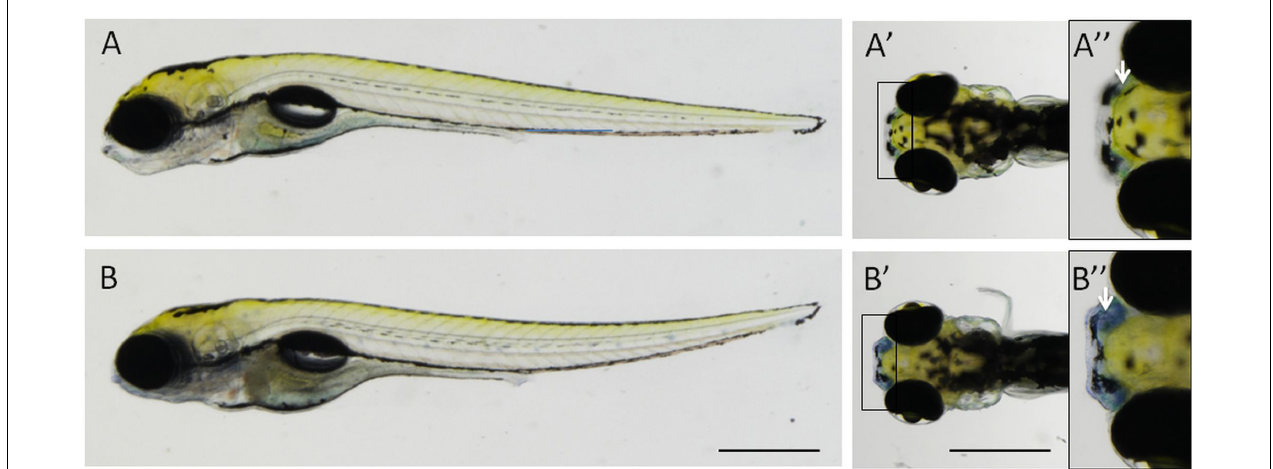
FIGURE 2 | Nile blue staining distinguishes npc2 − / − fish from wildtype and heterozygous siblings. The strong signal could be detected in the peripheral olfactory organ in 5-day-old npc2 − / − larvae (B–B”) , unlike their siblings (A–A”) . (A,B) lateral view; (A’,A”,B’,B”) dorsal view; and (A”,B”) enlarged fragments of A’,B’ , respectively. Arrows indicate the position of the olfactory organ. Scale bar = 0.5 mm.